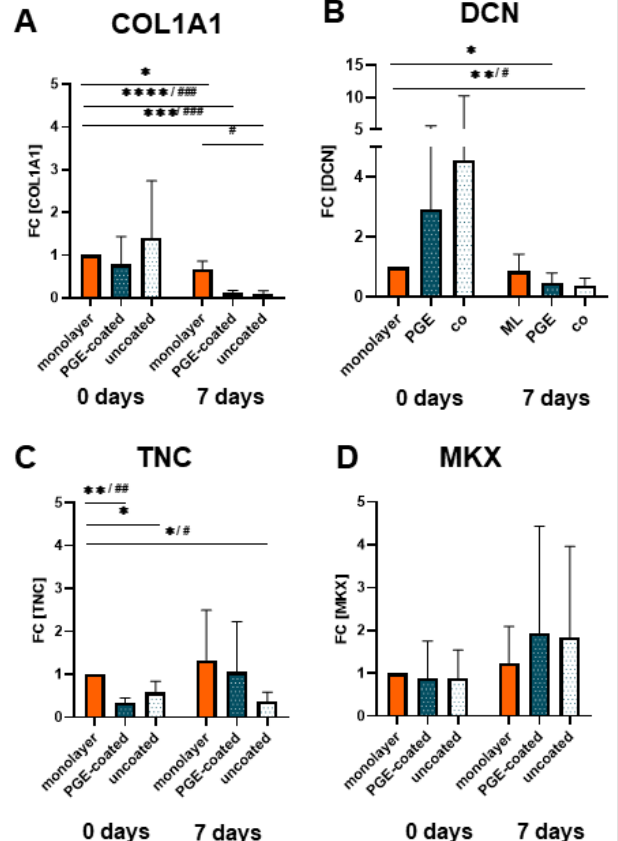
Figure 5. Gene expression of ligamentocytes cultured in the monolayer or as cell sheets after detachment (0 d) and when cultured for 7 d. ( A ) Type I collagen (COLA1, type I collagen A1 chain), ( B ) decorin (DCN), ( C ) Tenascin C (TNC) and ( D ) Mohawk (MKX) expression in monolayer, poly(glycidyl ether) (PGE)-coated and uncoated plates after 0 and 7 d, n = 4 independent experiments with ligamentocytes of four different donors. Statistic: One sample t-test, two-tailed (comparison with day 0 monolayer) (*), paired one-way ANOVA (comparison between the groups) (#), Grubbs test ( α = 0.05). p values: */# <0.05, **/## <0.01, ***/### <0.001, ****/#### <0.0001 ( A – D ).